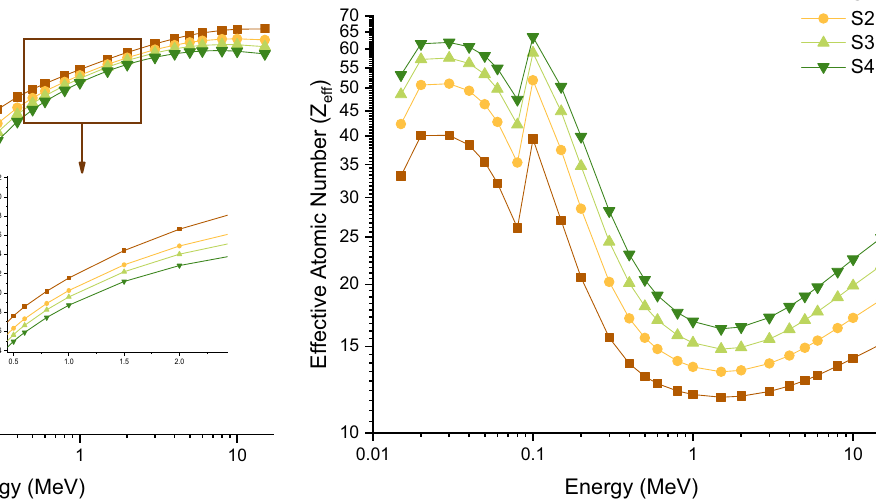
Figure 11: Variation of e ff ective atomic number ( Z e ff ) with photon energy ( MeV ) for all S1 – S4